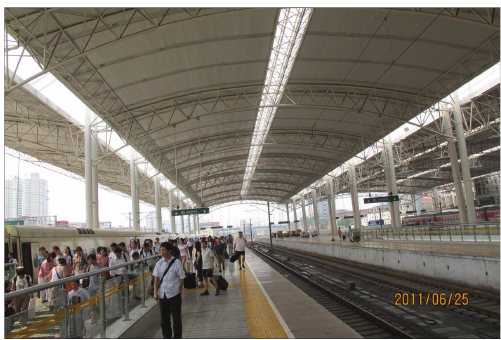
Figure 4: Medium- or small-sized station scenario.